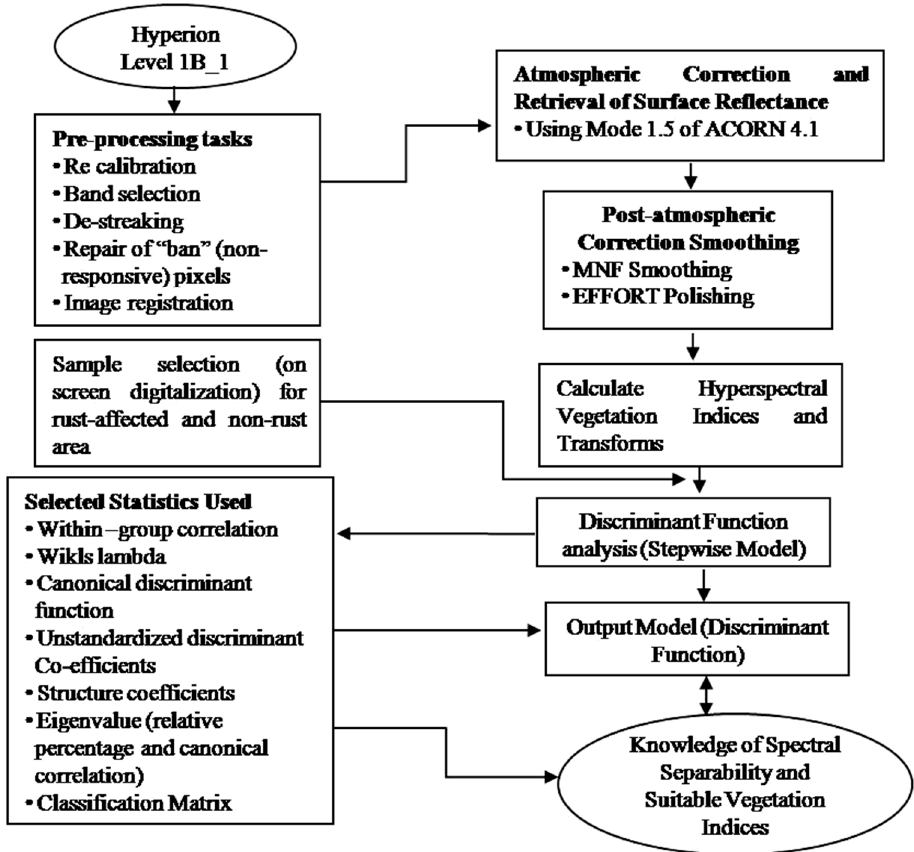
Figure 5. Main steps in the hyperion image processing for spectral differentiation of orange rust sugarcane adapted from Apan & Held et al.[64].